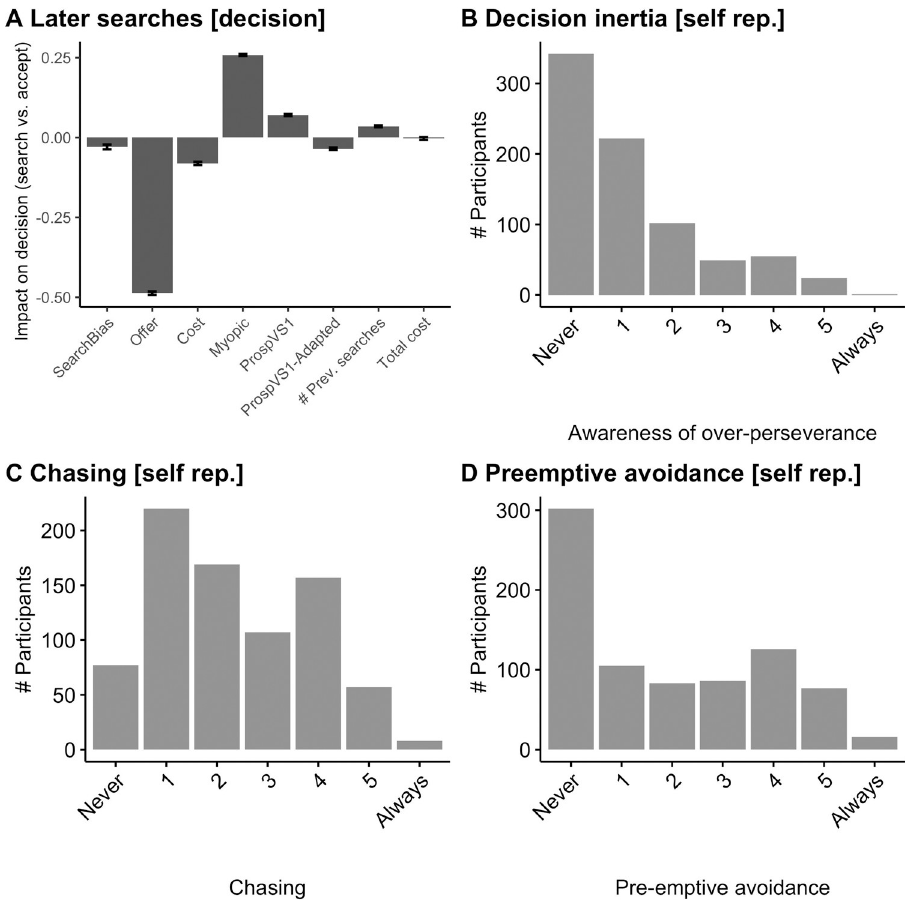
Fig 2. Group-level results (confirmation sample). (A) After initiating a search sequence, participants made a series of decisions of either banking an offer (and ending the trial) or searching again. We can assess, using our computational model (methods section “Analysis—Decisions”), whether participants behave mostly rationally and also whether they have decision inertia, i.e., show a “stuck in the rut” bias or a cost insensitivity bias. As in the discovery sample and as they should rationally, we found participants were more likely to go on searching if the myopic value was high (mean = 0.26, 95% CI [0.26 to 0.26]), if the initial prospective value (“ProspVS1”; i.e., the prospective value at the first search on each trial) was high (mean = 0.07, 95% CI [0.07 to 0.07]) or if the cost of searching was low (mean = − 0.08, 95% CI [ − 0.08 to − 0.08]) or if the drawn offers were low (mean = − 0.49, 95% CI [ − 0.49 to − 0.48]). Participants also adjust their estimate of prospective value (“ProspVS1-Adapted”) as it decreased over time as fewer and fewer available searches remained in a trial (mean = − 0.03, 95% CI [ − 0.04 to − 0.03]). We also found evidence for decision inertia (“stuck in a rut” bias, “# Prev. searches”): The more participants had already searched, the more likely they were to search again (mean = 0.04, 95% CI [0.03 to 0.04]). We tested participants sunk cost fallacy, i.e., whether they were more likely to continue searching the more costs they had already paid on a trial. However, this was not the case (“TotalCost” is not positive, (mean = − 0.00, 95% CI [ − 0.00 to − 0.00]). (B) Despite the strong behavioural effects of decision inertia, about half of the participants reported having no such bias (self-report Q 1). (C) Contrary to this, about 80% of people reported having been biased towards overchasing a rewarding option at least somewhat (self- report Q2). (D) About half of participants reported preemptively avoiding trials when they were worried they might spin the wheel too many times (self-report Q3). Error bars show Bayesian 95% credible intervals (2 tailed), significance is shown by credible intervals not including zero. Data in panel A are available in S9 Data (raw data in S1 Data) and panels B to D in S2